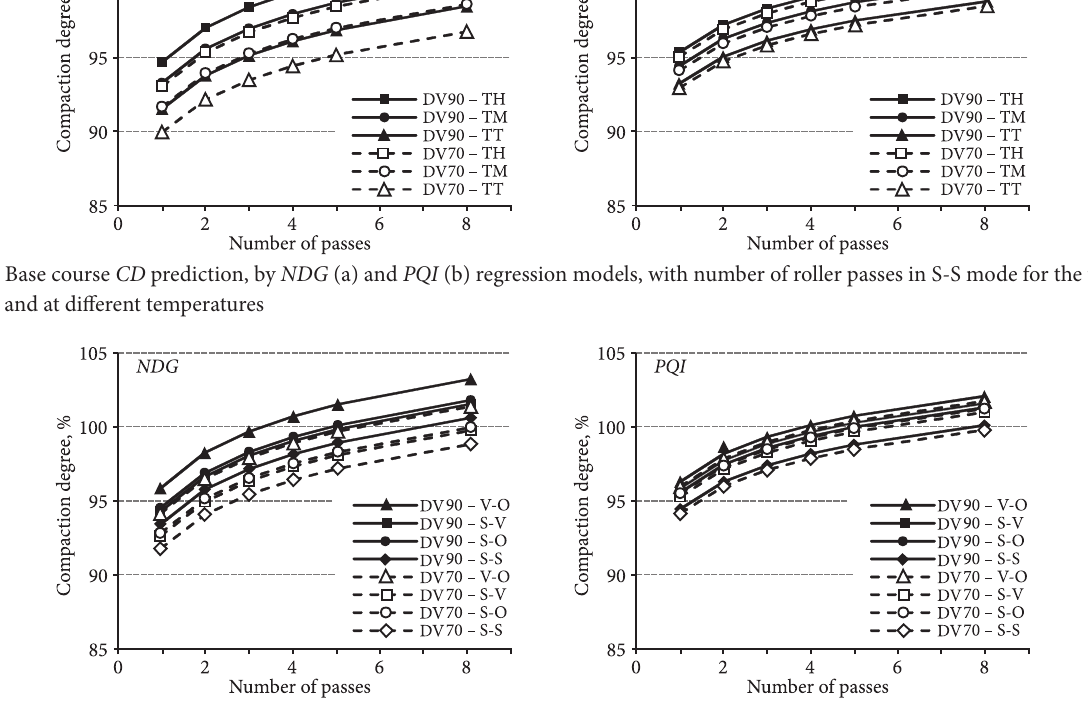
fig. 9. Base course CD prediction, by NDG (a) and PQI (b) regression models, with number of roller passes for the two rollers working at different compaction modes and at intermediate layer